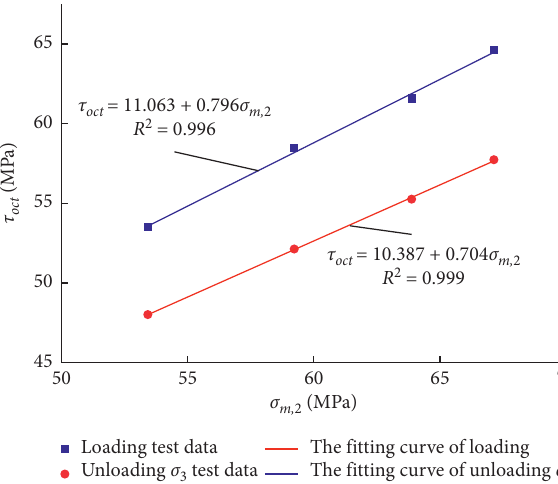
Figure 5: Specimen strength fitting curves based on the Mogi–Coulomb criterion. Table 2: Fitting parameters of sandstone under different stress